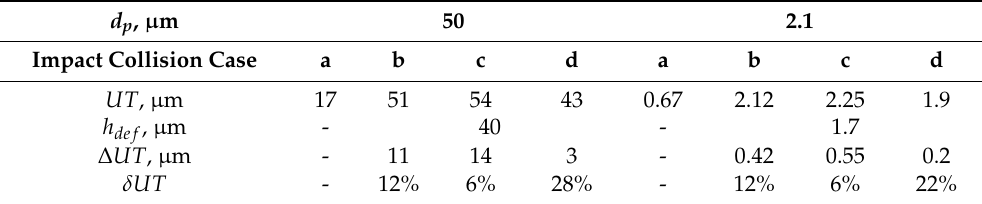
Table 2. Maximum and relative values for the penetration depth of 2.1 and 50 µ m particles for the different collision